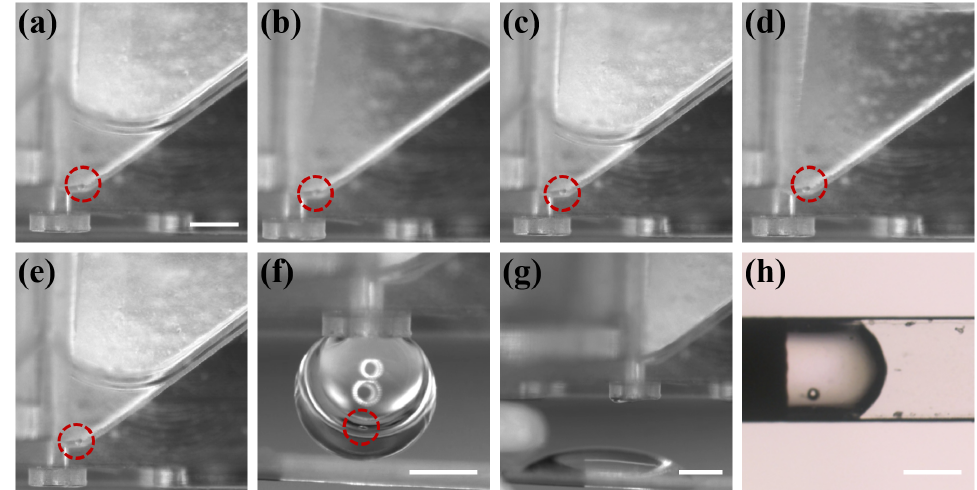
Figure 8. The microparticle was tracked by the imaging system over the entire process of system vitrification. ( a ) The operator placed the microparticle in the chip. ( b – g ) The microparticle completed vitrification pretreatment and was transferred to Cryotop. ( h ) The droplet on Cryotop contained microparticle. Scale bars in ( a , f , g , h ) are 400 µ m.